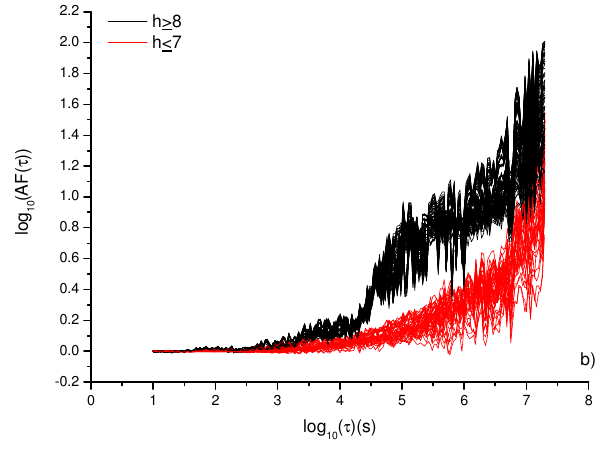
Fig. 5. AF curves for changing threshold magnitude and depth.